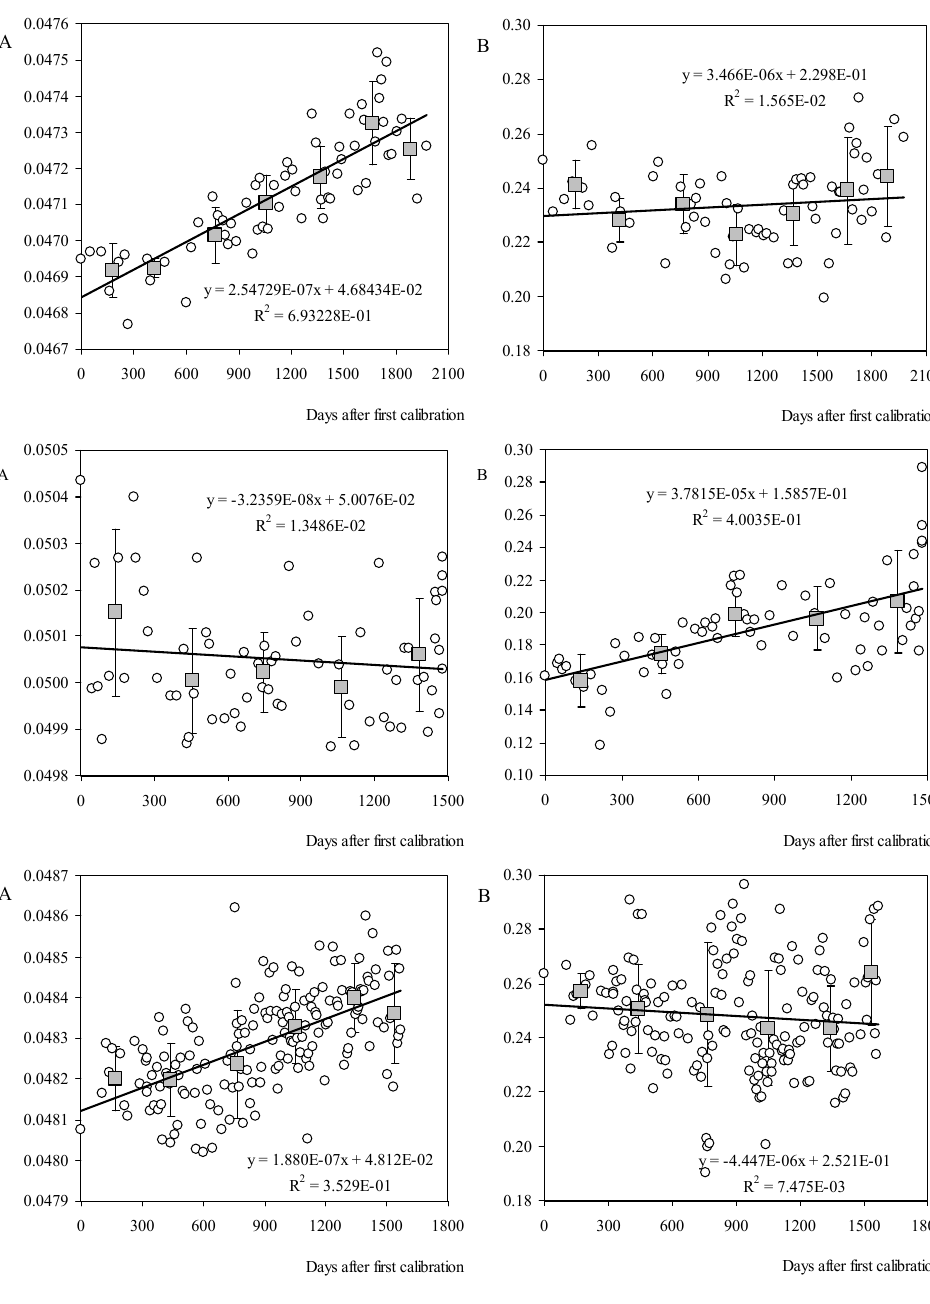
Figure 1. Calibration coefficients’ variation with regard to IDR/UPM Institute anemometers: Climatronics 100075 (top), Vector Instruments A100 L2 (middle), and Thies Clima 4.3350 (bottom) cup anemometers. These coefficients were measured in different calibrations from January 2001 to June 2006 (Climatronics 100075), from September 2003 to September 2007 (A100 L2), and from November 2006 to August 2010 (Thies Clima 4.3350). The 300-day average value has been included, together with the standard deviation bars. The linear fitting to the data has been also included.